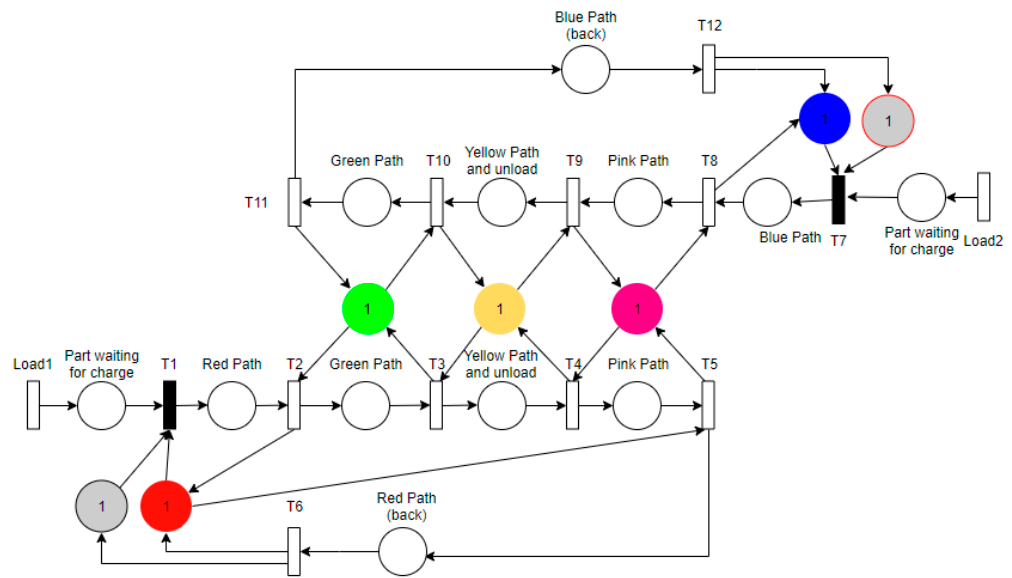
Appl. Sci. 2020 , 10 , x FOR PEER REVIEW Figure 16. Case IV: initial marking of Petri net. Figure 16. Case IV: initial marking of Petri net.